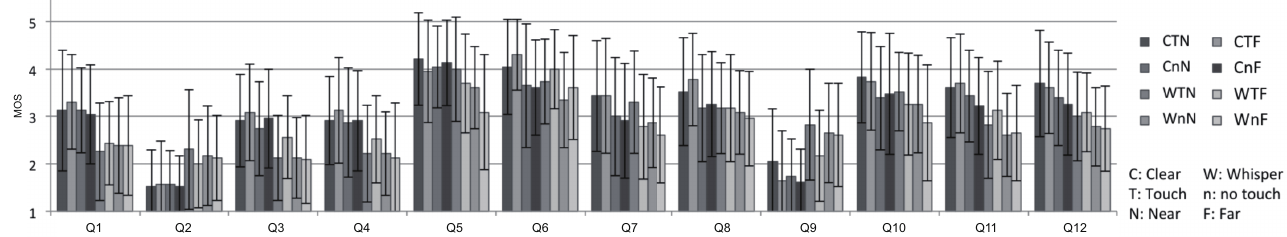
Figure 2: Results of subjective evaluation